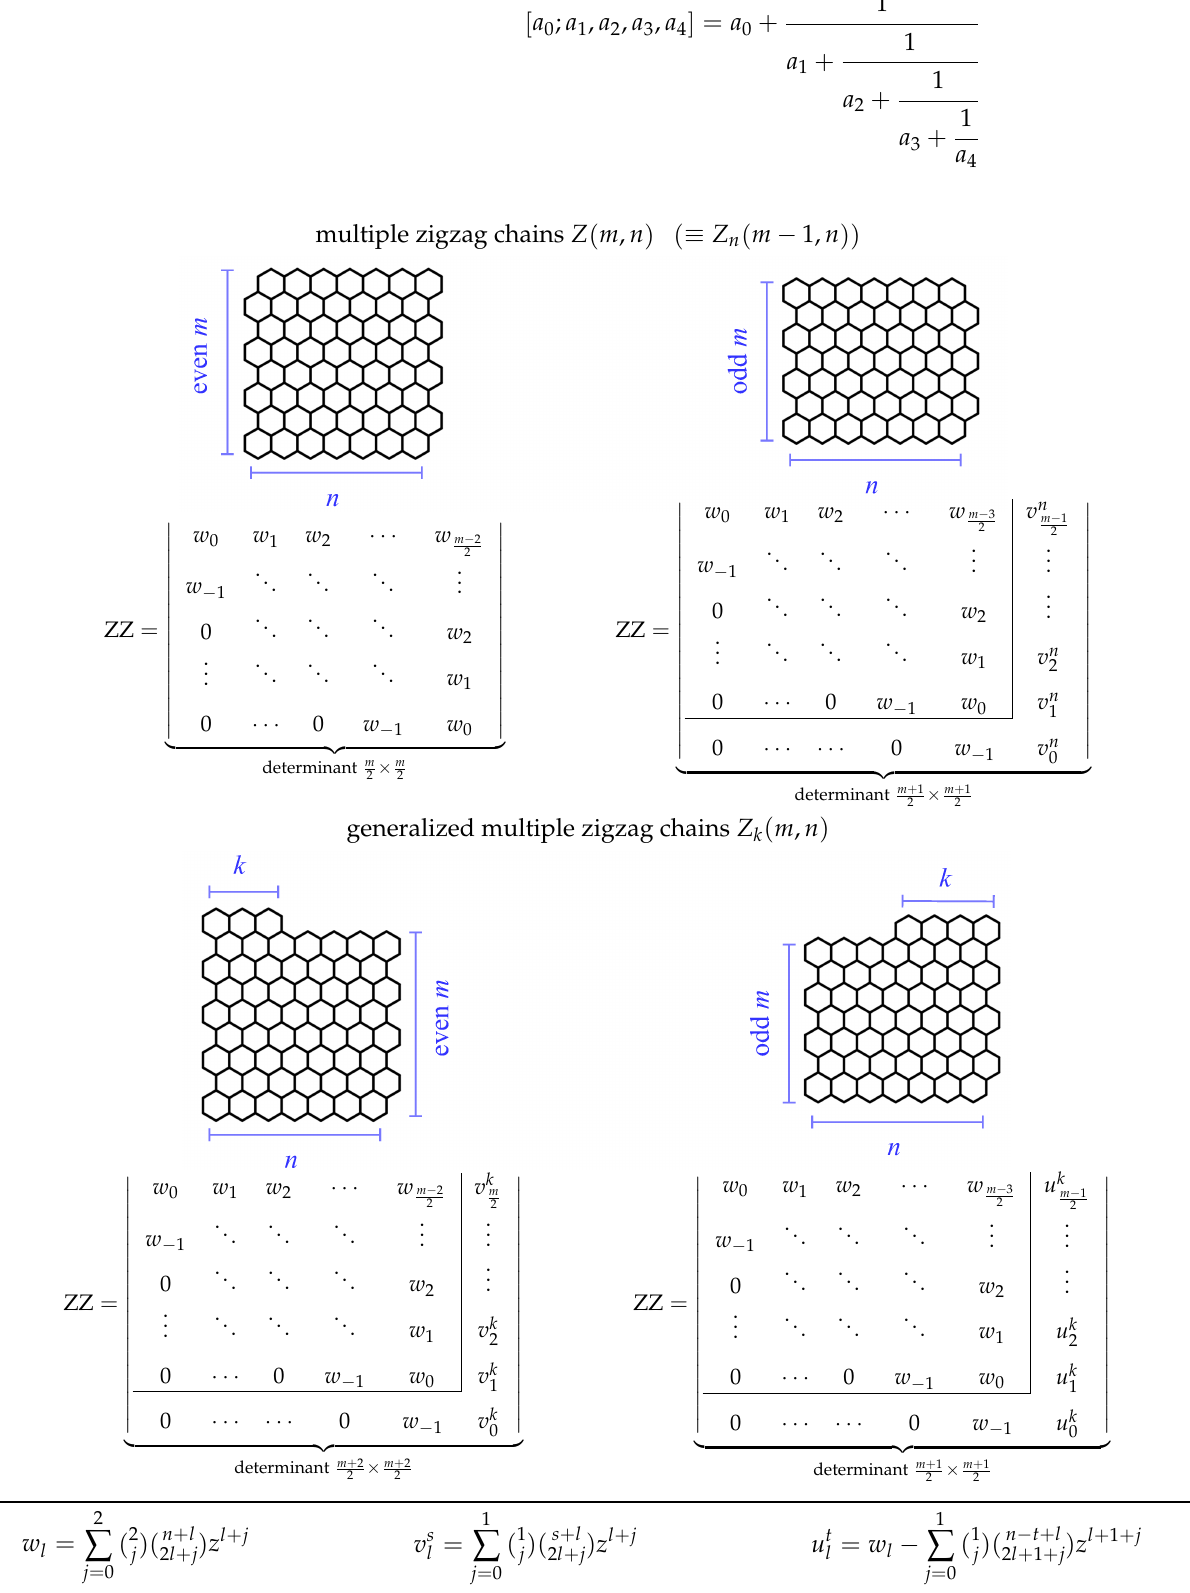
Figure 2. Zhang–Zhang (ZZ) polynomials of multiple zigzag chains Z ( m , n ) and generalized multiple zigzag chains Z k ( m , n ) can be expressed as determinants of Toeplitz or almost-Toeplitz matrices. The matrix elements are given in the oval frame or by Equations